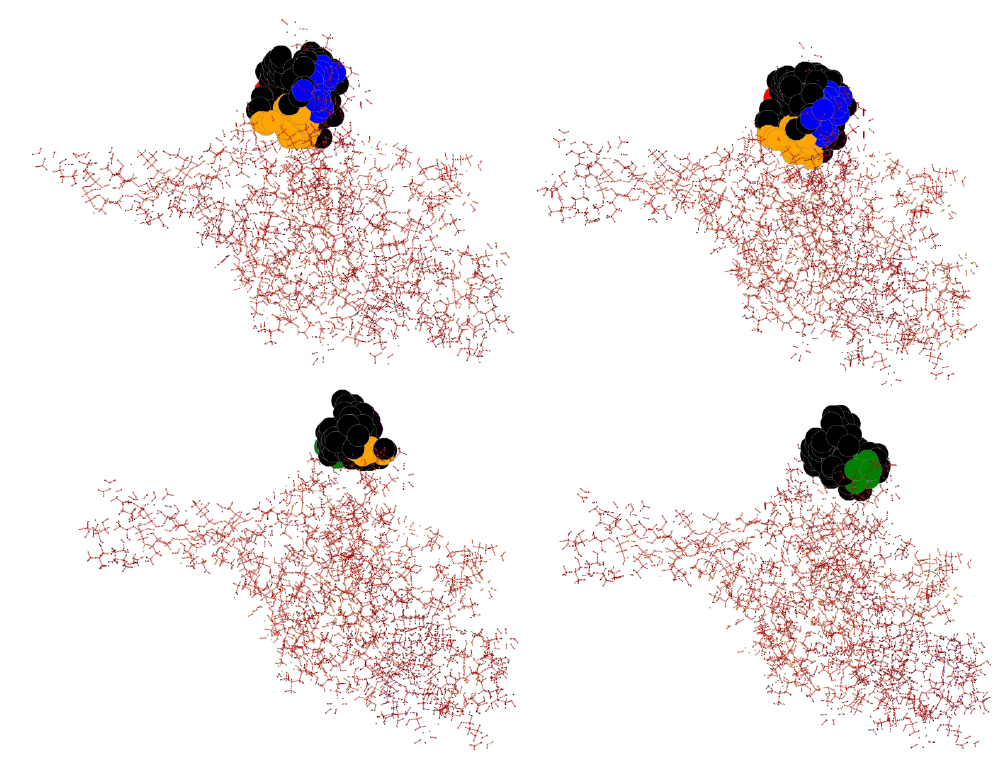
Figure 8. Visualization of the largest 5 rigid clusters at the site of the InDel/substitution for the Cypovirus Polyhedra proteins: 5YR9 with single substitution ( top-left ), 5GQI with single deletion ( top-right ), 5GQN with three deletions ( bottom-left ), and 5GQJ with two deletions ( bottom-right